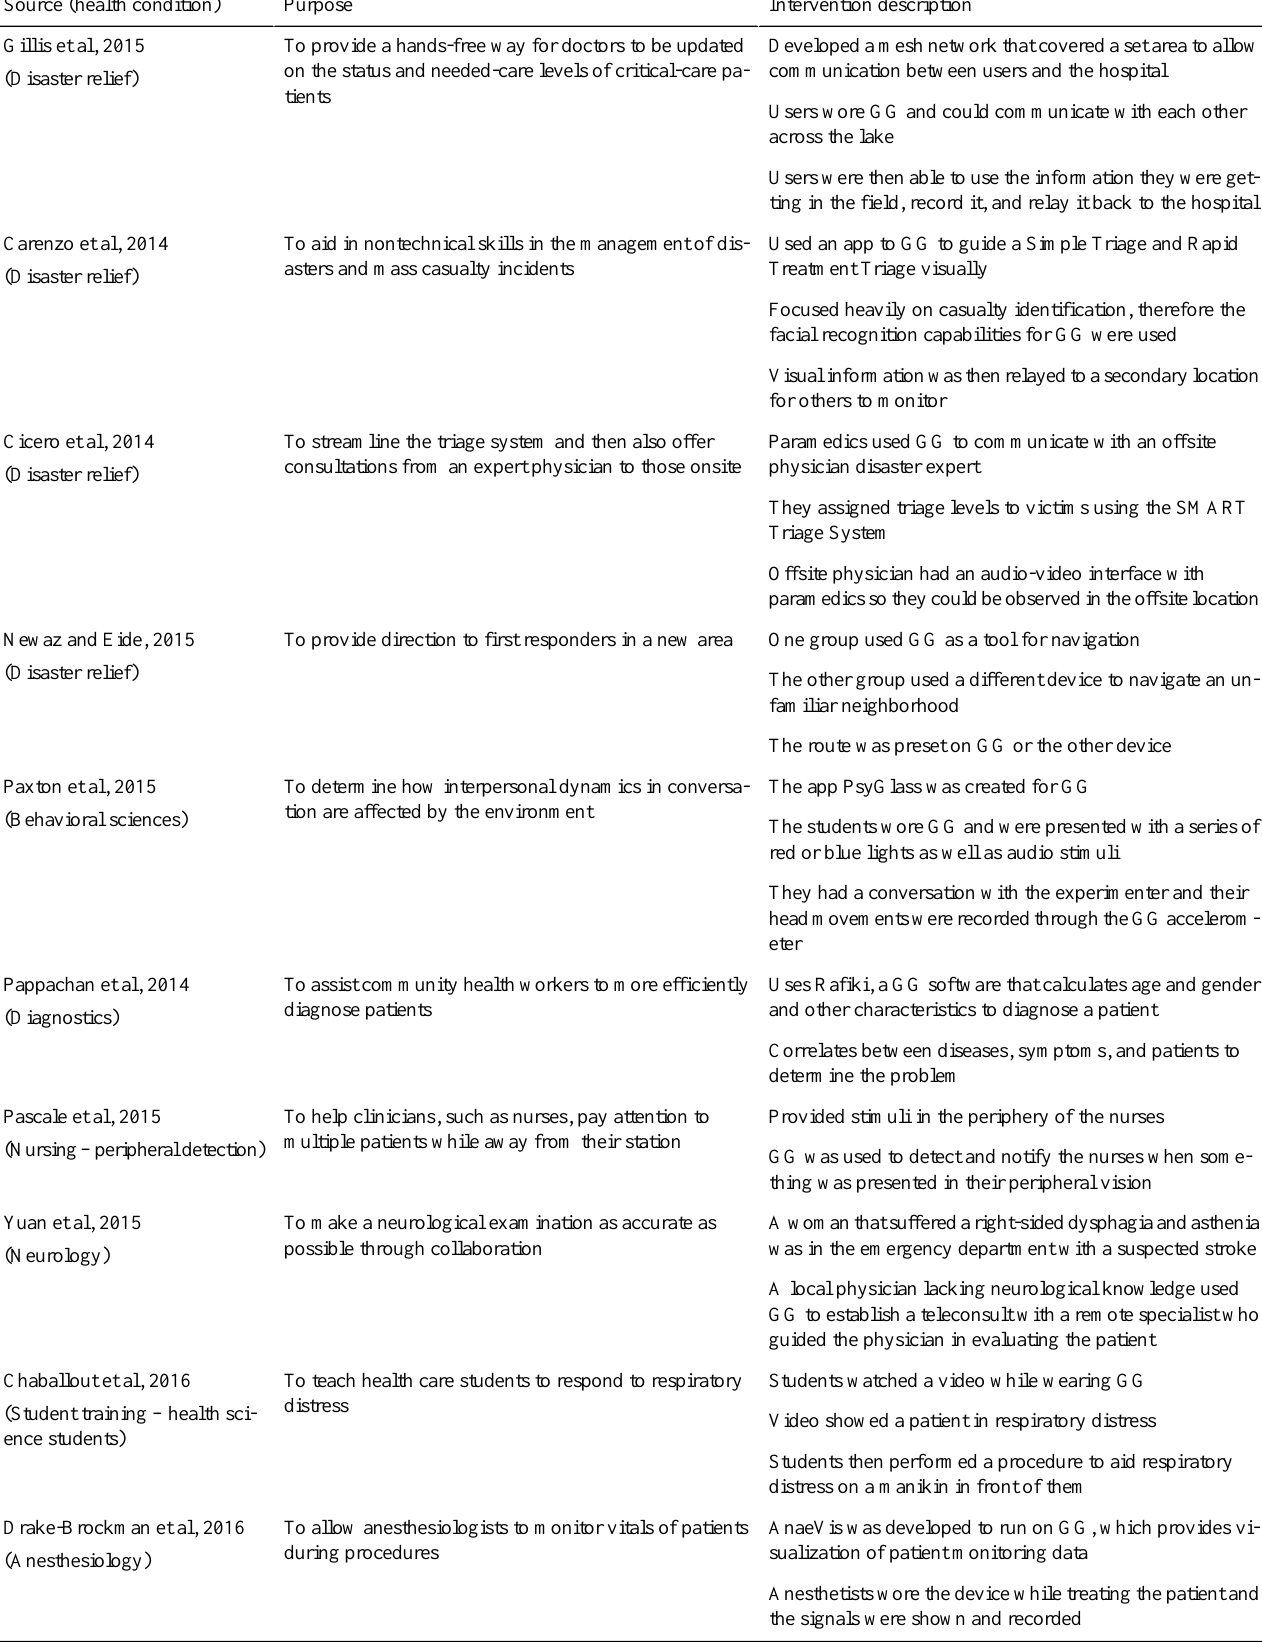
Intervention descriptionPurposeSource (health